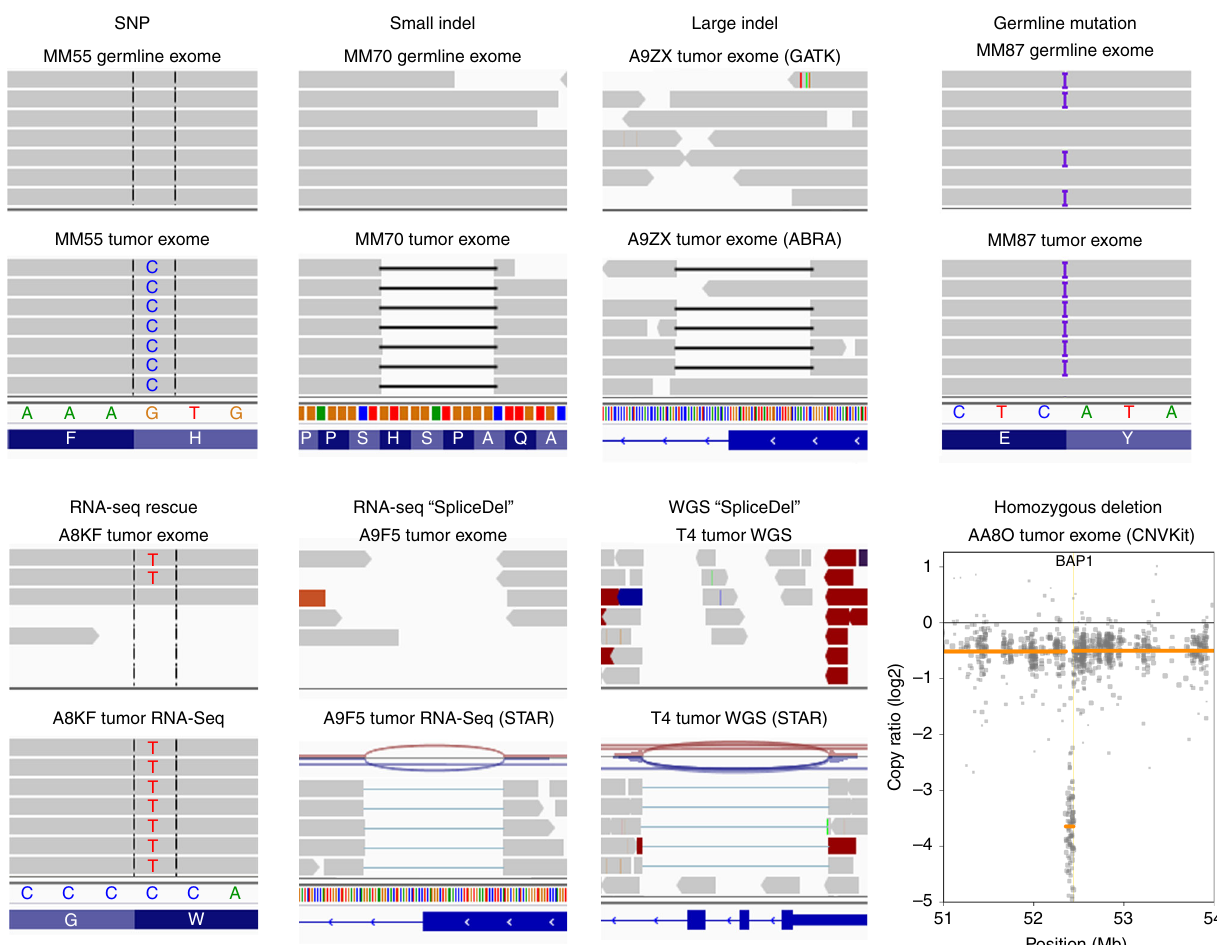
Fig. 2 BAP1 mutation diversity and necessary detection methods. Standard somatic mutation callers (i.e., Varscan2 and MuTect2) can detect SNPs (SNP) and small indels (small indel). Large indels need specialized realignment (i.e., with ABRA) for detection, as these can be missed with IndelRealigner and/or Mutect2 (large indel). Somatic mutation callers exclude germline mutations, so blood samples need to be run with a germline mutation caller (e.g., HaplotypeCaller) or as an unmatched “ tumor ” with a somatic caller (e.g., MuTect2) to detect patients with BAP1 hereditary cancer